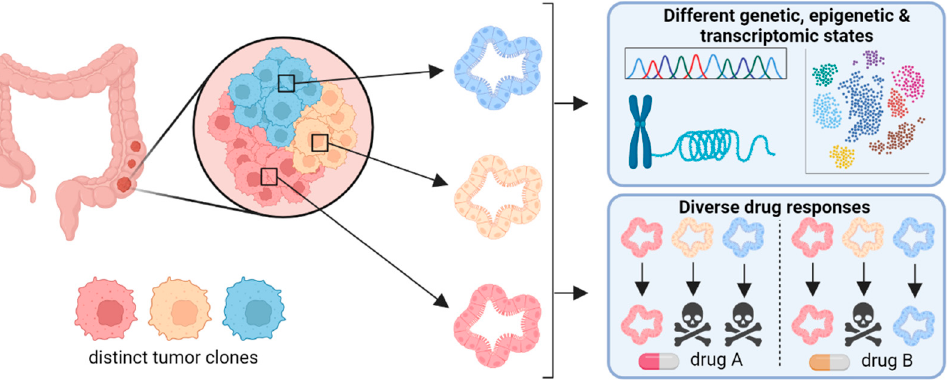
Figure 2. Organoids as tool to dissect intratumor heterogeneity. Generating organoids from various regions of an individual tumor enables to interrogate subclones for differences in the genome, epigenome, and transcriptome. The clonal organoids can also be tested for their sensitivity towards various drugs or drug combinations, therefore serving as surrogate system for personalized medicine.